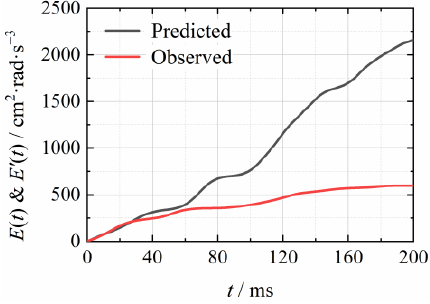
Figure 10. E ( t ) and E ’( t ).